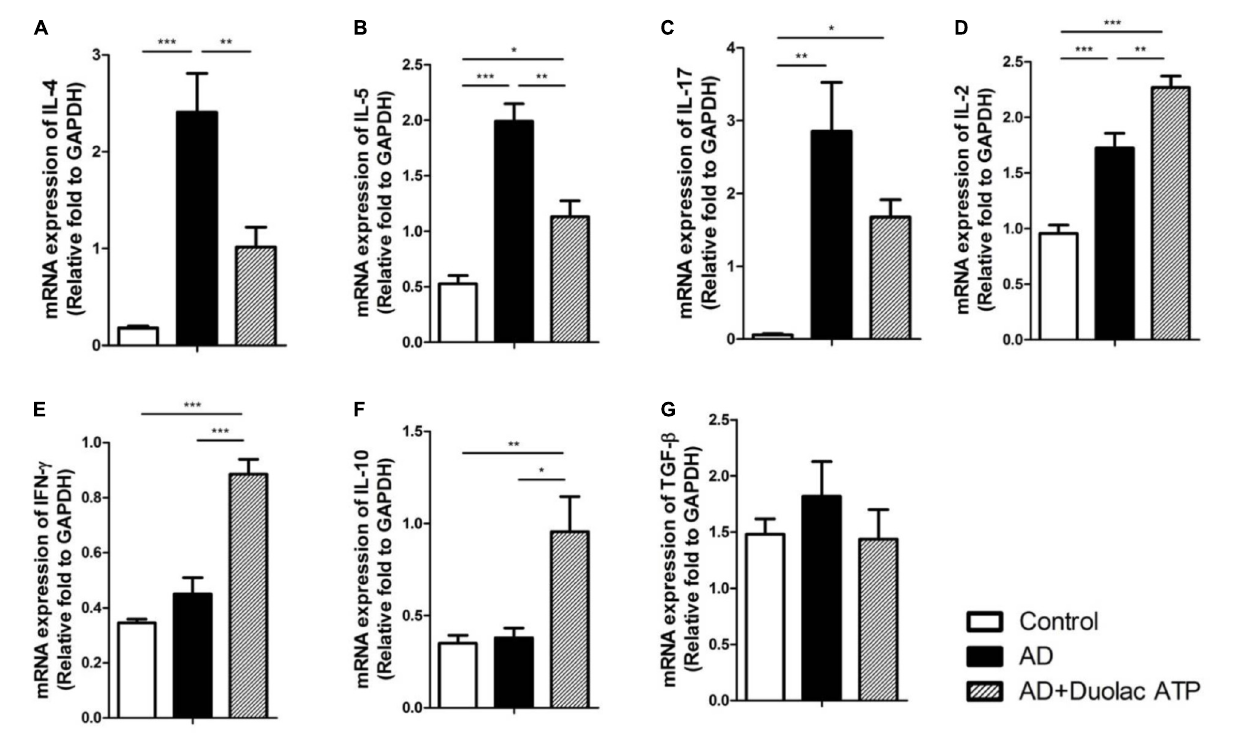
FIGURE 5 | mRNA expression of cytokine levels from PBMCs in HDM-sensitized Nc/Nga mice treated with Duolac ATP. Nc/Nga mice ( n = 6 per group) were sensitized by exposing them to HDM extracts six times over 3 weeks. They were then subjected to oral administration with Duolac ATP. PBMCs were collected at week 4, and RNA was extracted for cDNA synthesis. qPCR was performed to examine the mRNA expression of (A) IL-4, (B) IL-5, (C) IL-17, (D) IL-2, (E) IFN- γ , (F) IL-10, and (G) TGF- β . Relative fold changes of target genes were compared with that of the housekeeping gene, GAPDH. ∗ P < 0.05, ∗∗ P < 0.01, ∗∗∗ P < 0.001 using one-way ANOVA with Tukey’s multiple comparison test. Bars indicate mean ±